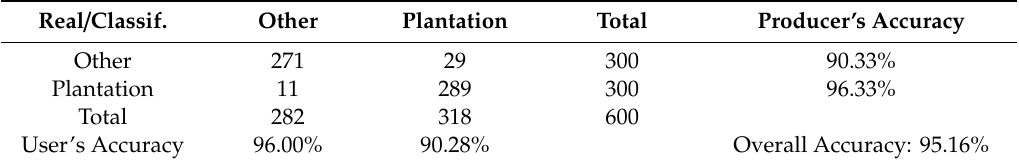
Table 7. Evaluation of chestnut plantation area predictions obtained using Model 4 (model created applying XGBoost). Ground truth data were created with a random stratified sample of 600 points. Real/Classif.